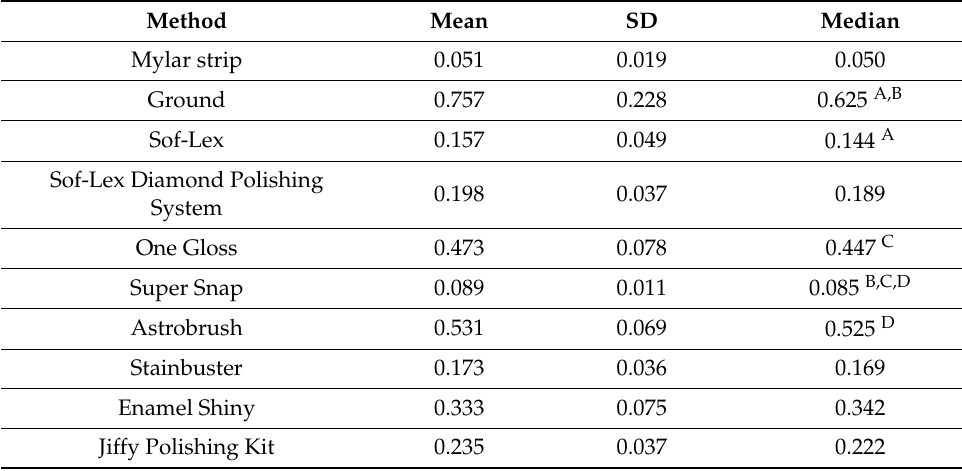
Table 4. Descriptive statistics, Ra [ µ m] for Filtek Z250.